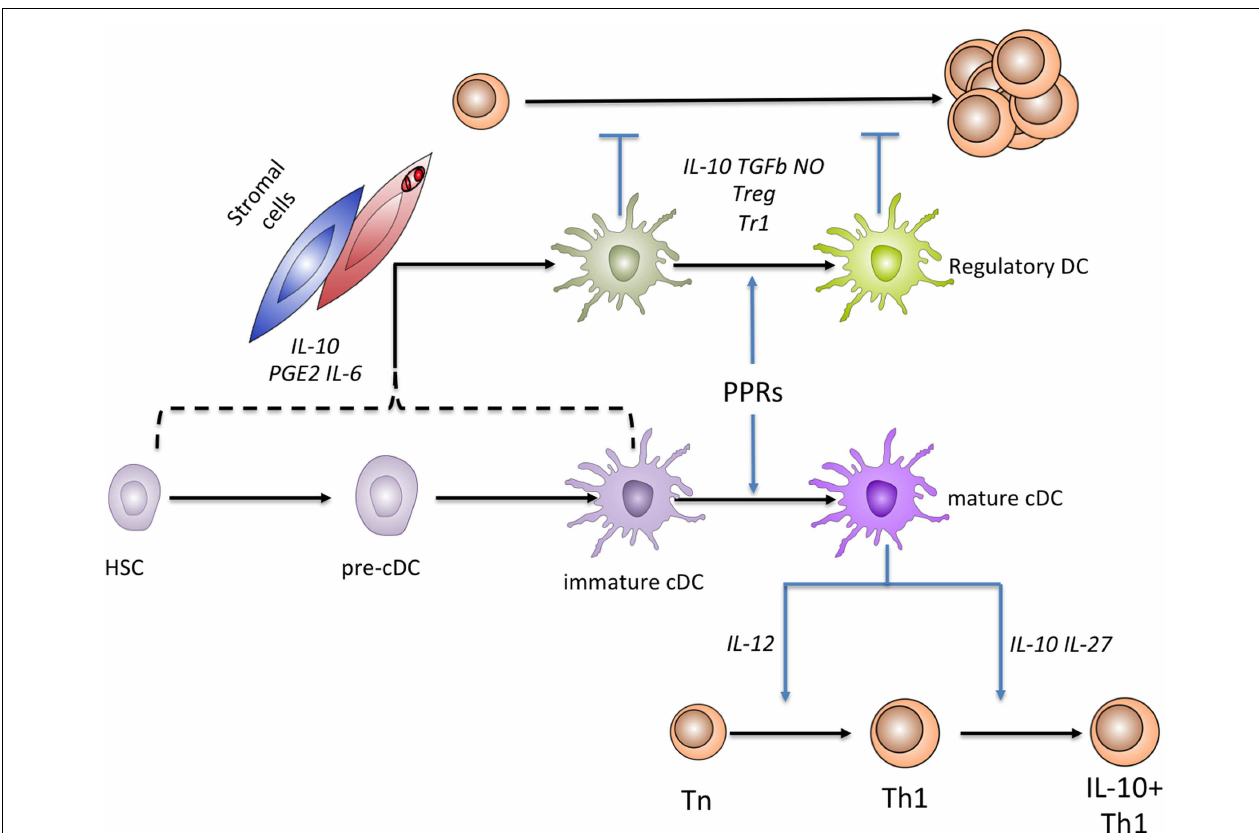
c-kit + progenitors by production of PGE 2 , IL-6, and IL-10, as well as direct interactions mediated by Fibronectin. During the chronic inflammation associated with L. donovani infection, IL-10-producing rDC generation is enhanced by the production of CCL8 and CXCL12 by splenic stromal cells that in many cases are directly parasitized (red).The stage(s) of development at which cDCs or their precursors are able to differentiate into regulatory DCs is not yet defined. Functionally, regulatory DCs are best defined by their capacity to inhibit the proliferative capacity ofT cells. rDCs employ multiple mechanisms to suppress naïveT cell proliferation, including the direct production of IL-10 and the induction of FoxP3 + nTreg and IL-10 + Tr1Treg